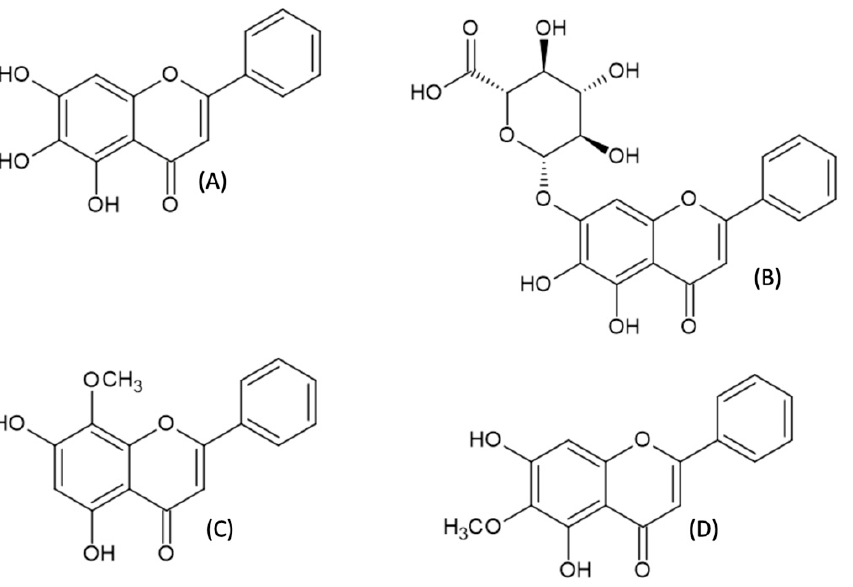
Figure 1. Structures of selected compounds extracted from Scutellaria baicalensis; baicalein ( A ), baicalin ( B ), wogonin ( C ), and oraoxilin A ( D ).